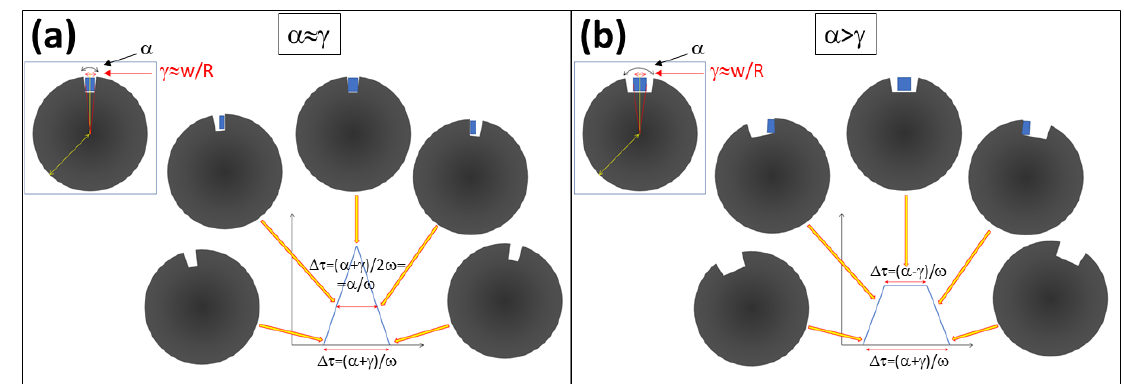
Figure 2. Schematic illustration of the ( a ) triangular pulse shape, where the chopper slit opening is equal to the guide opening; and ( b ) trapezoidal pulse shape, where the chopper slit opening is larger than the guide opening, showing the rise/decay process and how the relationship between α and γ determines the pulse shape.